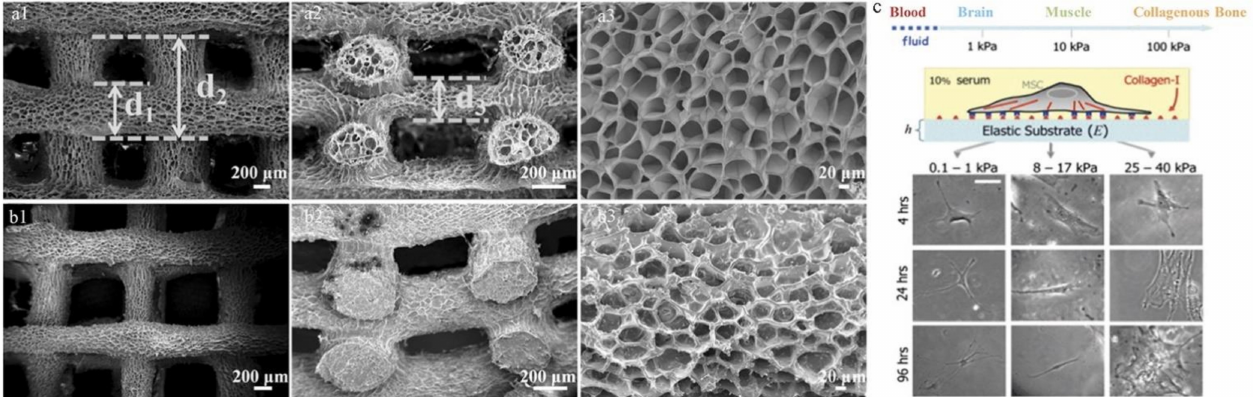
Figure 7. SEM images of the printed porous PNT-35%-6 hydrogel scaffolds ( a1 – a3 ) and the PNT-35%-6- β -TCP-22% hydrogel scaffolds ( b1 – b3 ). Top-down micrographs ( a1 , b1 ), cross-sectional view ( a2 , b2 ), and high magnification view of the surfaces ( a3 , b3 ), where d 1 is the experimental printed filament diameter, d 2 is the fiber spacing, and d 3 is the layer thickness in the vertical dimension of each scaffold [77]. ( c ) The effect of material stiffness on cellular adhesion, differentiation behavior, and cell shape; the cells show branched and spindle shapes. The scale bar is 20 µ m